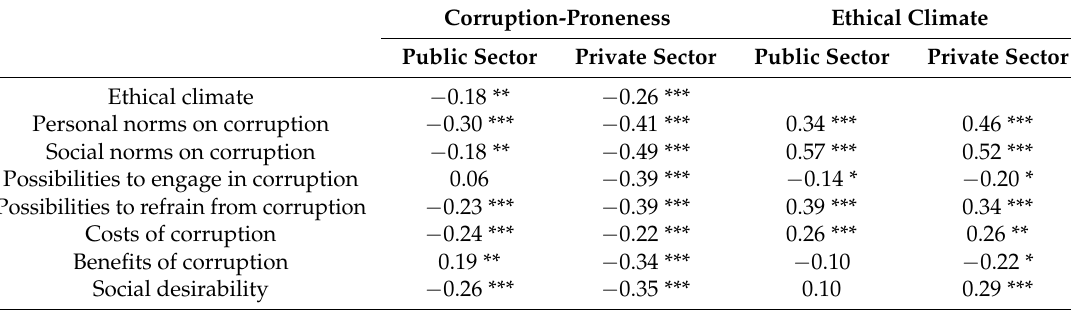
Table 2. Simple correlations between corruption-proneness, ethical climate, and the motives for corruption, disaggregated for the public sector ( n = 234) and the private sector ( n =